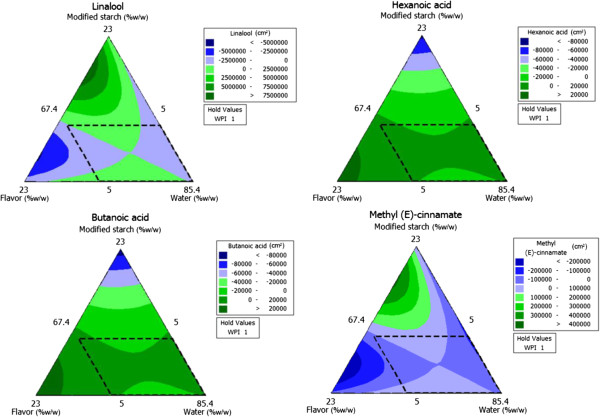
Mixture contour plots of four soursop flavor compounds. Diamond-shaped subregion is the constrained experimental region.